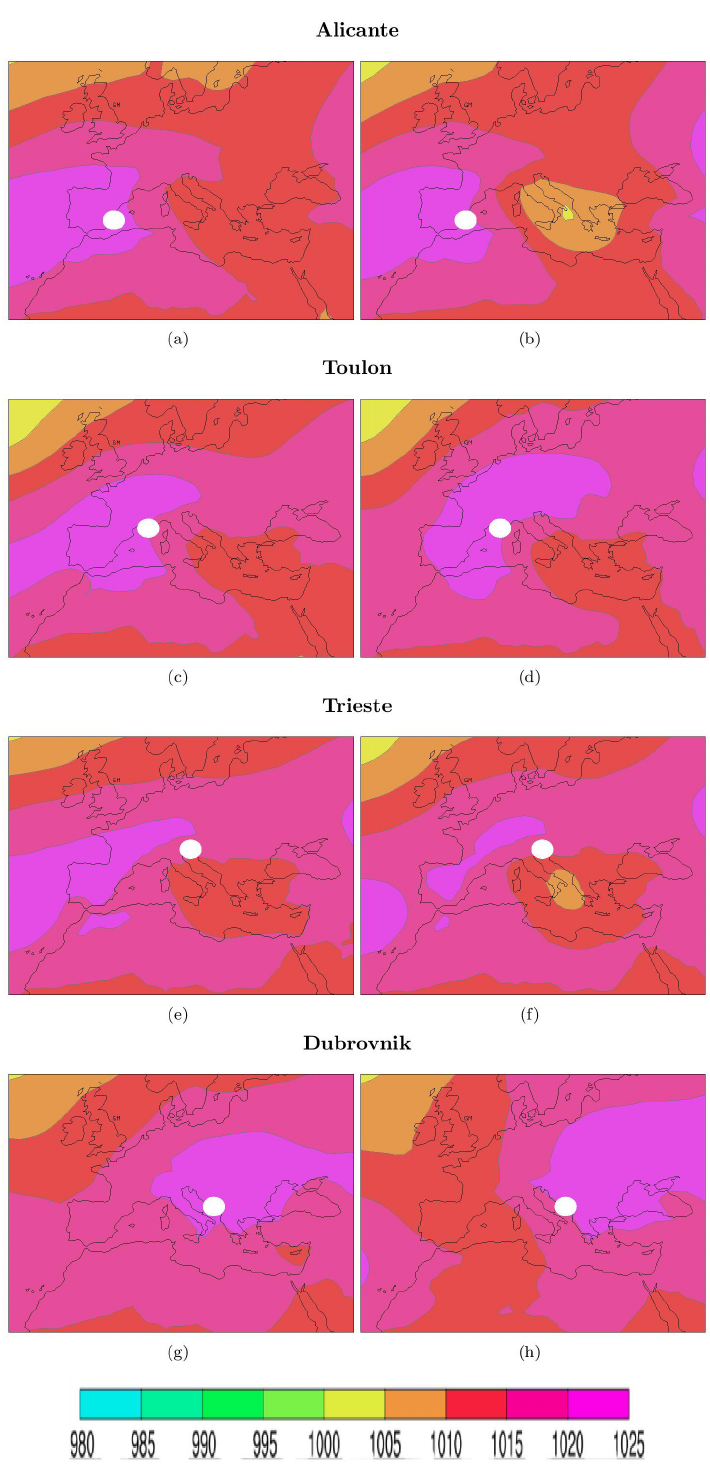
Figure 3. The same as Fig. 2 but for large negative